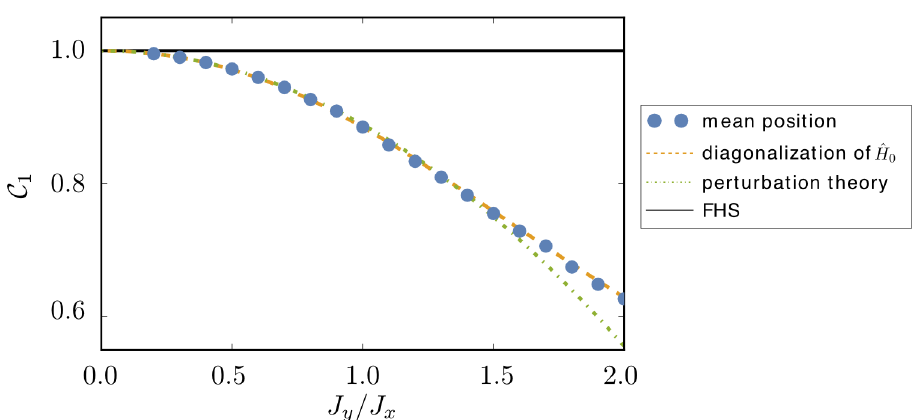
π / J = 3. We , for Φ = 2 and N y x y 3